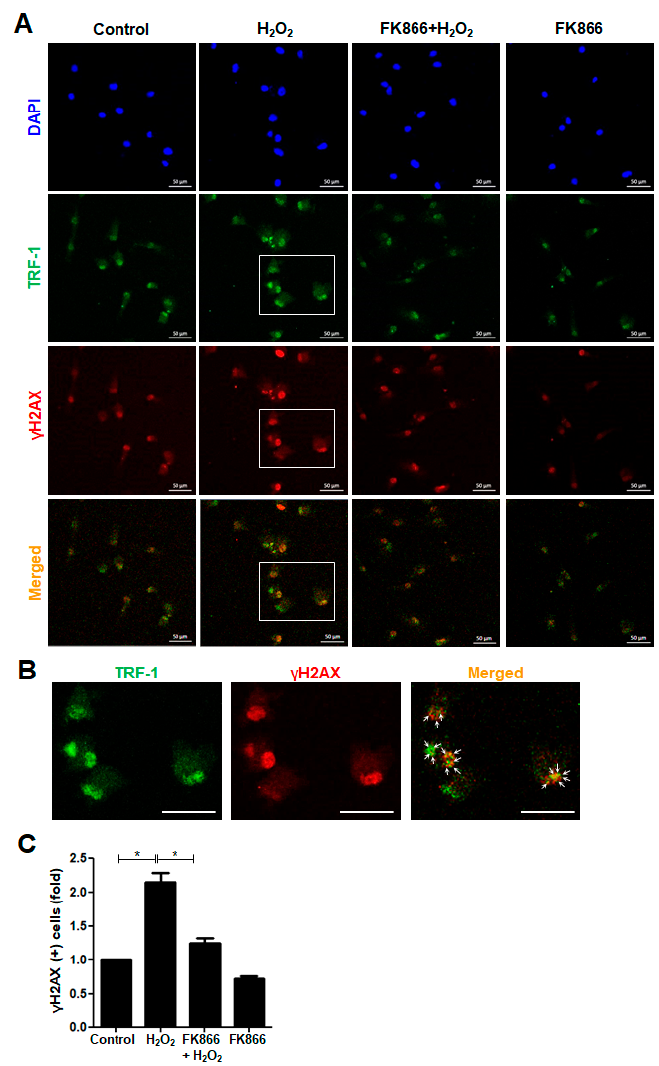
Figure 2. Effect of FK866 on H 2 O 2 -induced telomere damage formation in hDPCs. The hDPCs were pretreated with FK866 (10 μ M) for 2 h and then stimulated with H 2 O 2 (400 nM) for 24 h. ( A ) Immunofluorescence analysis of TRF-1 (Alexa fluoro (AF)-488, green) and γ H2AX (AF-594, red) in hDPCs. The cells were analyzed using a confocal microscope. The nuclei were counterstained with DAPI (blue). ( B ) Higher magnification images of the boxed areas ( A ) showing double immunoreactivity (yellow) for TRF-1(green) and γ H2AX(red). Arrows in the merged images point to sites of colocalization. Scale bar: 50 μ m. ( C ) Quantitative result for the percentage of γ H2AX-positive cells. * p < 0.1.